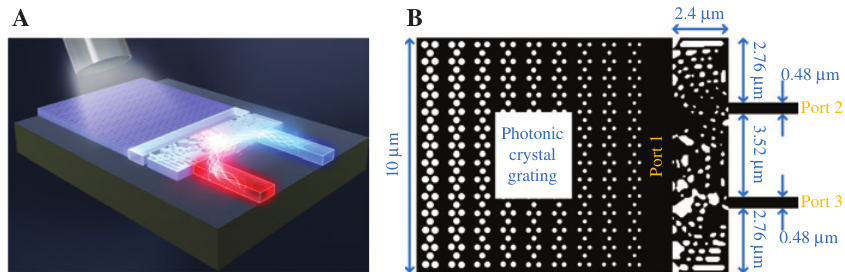
Figure 1: Schematic of the designed two-channel focused wavelength demultiplexer. Three-dimensional diagram (A) and top view